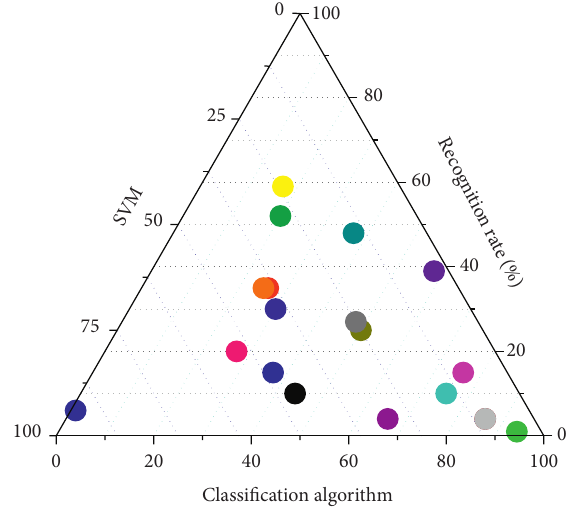
Figure 6: Comparison of identification results of different clas- sification